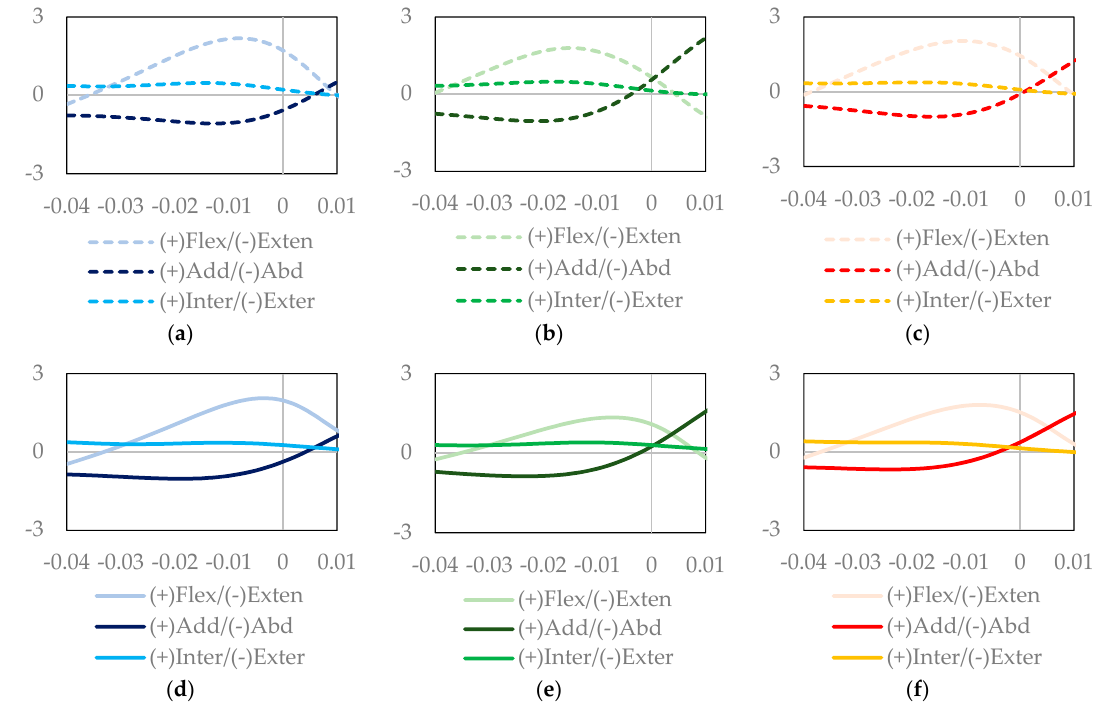
Figure 2. Hip joint torque ([Nm/kg]: vertical axis) of the mean transition value of all participants expressed with time ([s]: horizontal axis) from the impact: the result of the straight ( a ), curve ( b ) and knuckle ( c ) kicks in the pre experiment; the result of straight ( d ), curve ( e ) and knuckle ( f ) kicks in the post